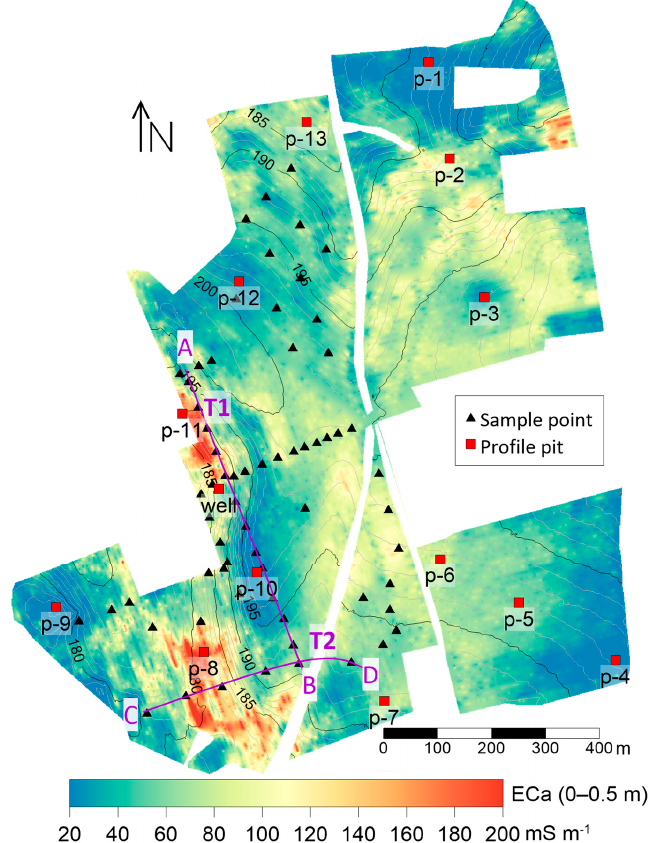
Figure 1. ECa (0–0.5 m) map of the experimental field, measured in 2013, with topography and locations of profile pits and sample points. Piezometers were installed at p-2, p-3, p-5, p-6, p-7, p-8, and p-13. Transects T1 ( A , B ) and T2 ( C , D ) are represented with continuous lines.